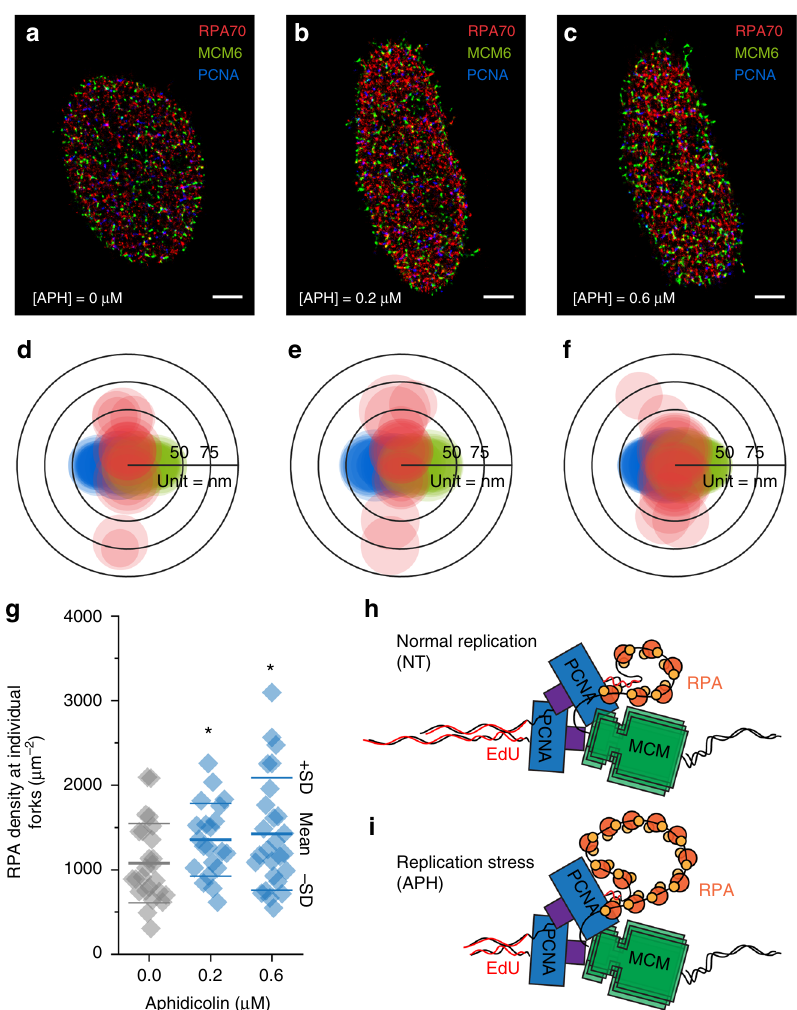
Fig. 4 RPA local density at individual replication forks estimated by the TC function. a – c Representative U2OS nucleus labeled with RPA70 (R), PCNA (B), and MCM (G) were treated with 0, 0.2, and 0.6 μ M Aphidicolin (APH), respectively. Scale bar = 2500 nm. d – f Con fi gurations resolved from N = 80, 95, and 101 nuclei treated with 0, 0.2, and 0.6 μ M APH, respectively (from 3 experimental replicates). Filtered by the criteria Dist_BG (distance between PCNA and MCM) ≤ 100 nm, 25, 21, and 26 con fi gurations from [APH] = 0, 0.2, and 0.6 μ M, respectively, were overlaid by aligning the BG edge onto the same horizontal, so that the relative distribution of PCNA (B) to RPA70 (R) and MCM (G) is clearly seen to form a fork-like pattern where RPA were mostly found in between the PCNA and MCM. The circle size at each vertex represents the local density of RPA at each individual fork as calculated by multiplying the conditional probability of fi nding RPA with each given pairwise PCNA-MCM and the overall average density of RPA. g Statistics of the average local density of RPA at each individual fork (as displayed as the size of the circles in d – f ). Each plot displays such average local density from one nucleus. p = 0.043 and 0.036 for unpaired t-test between [APH] = 0 vs. [APH] = 0.2 μ M and [APH] = 0 vs [APH] = 0.6 μ M, respectively (*, unpaired t test, 0.01 ≤ p < 0.05). h , i A molecular model of RPA accumulating in between PCNA and MCM in non-treated control (Normal Replication, NT) cells ( h ) and APH stressed (Replication Stress, APH) cells ( i ). Source data for Fig. 4d-4j are provided as a Source Data fi